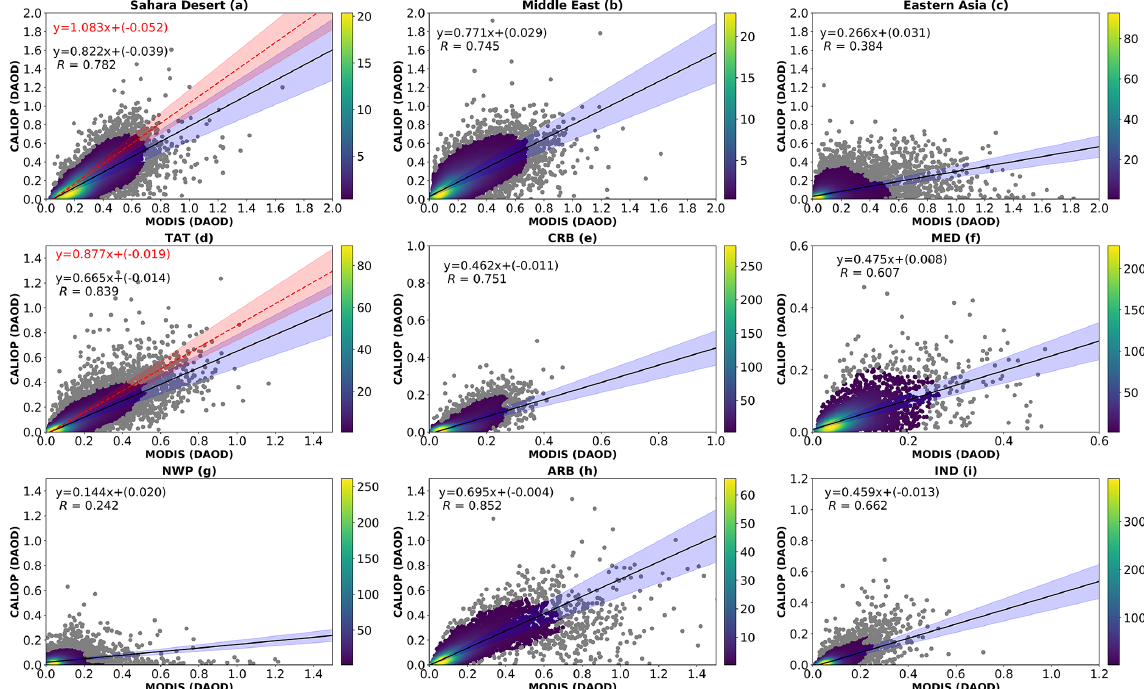
Figure 9. Comparison of CALIOP DAOD against MODIS DAOD over dust-laden regions indicated in Fig. 8. Color represents the probability density using Gaussian kernel density estimation. Gray points represent data points within the lowest 5% of data density. Those gray points are excluded in the linear regression analysis. The black line and blue shadow are the linear regression for LR = 44 ± 9sr; the red line and red shadow in panels (a) and (d) represent the linear regression for LR = 58 ± 8sr. The red text in panels (a) and (d) is the linear fit based on LR = 58sr. The black text in each panel is the linear fit based on LR = 44sr. R is Pearson’s linear correlation coefficient between MODIS and CALIOP